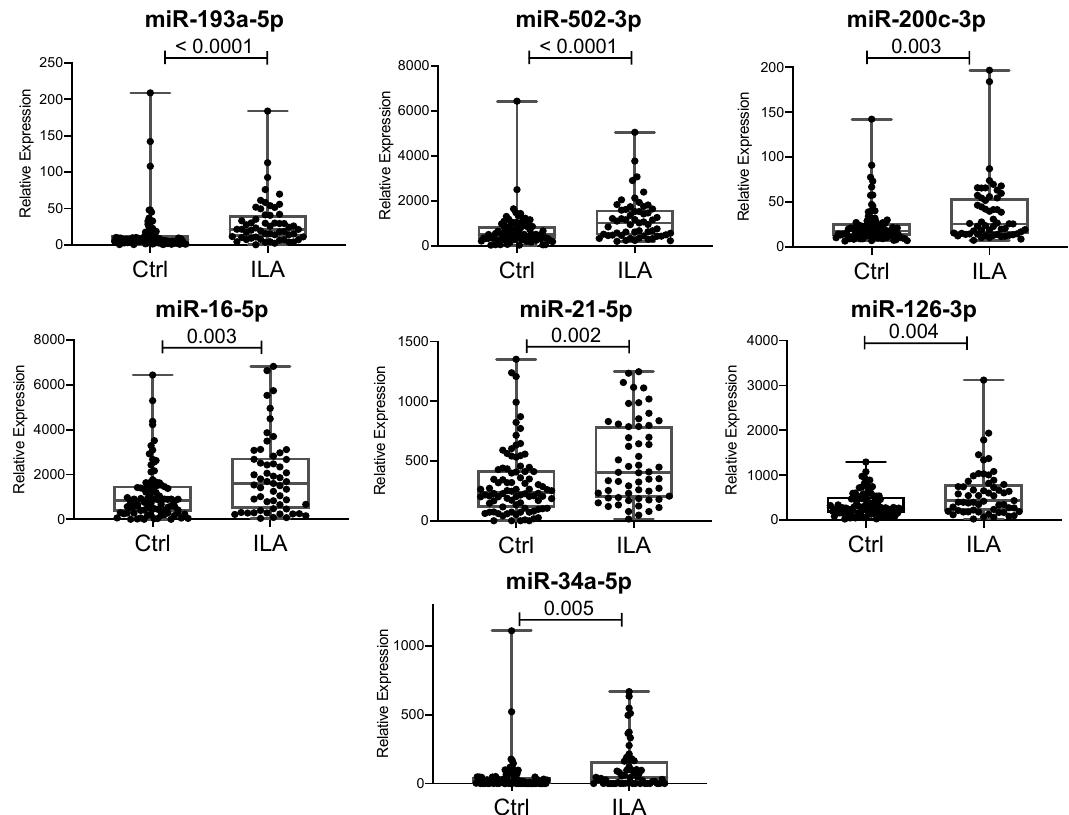
Figure 2. Validation of candidate miRNAs di ff erentially expressed in ILA subjects. Graphs show the quantitative real-time PCR analysis of di ff erentially expressed miRNAs in serum of ILA ( n = 57) compared to Ctrl ( n = 88) from the validation cohort. ILA: subjects with interstitial lung abnormalities. Ctrl: control